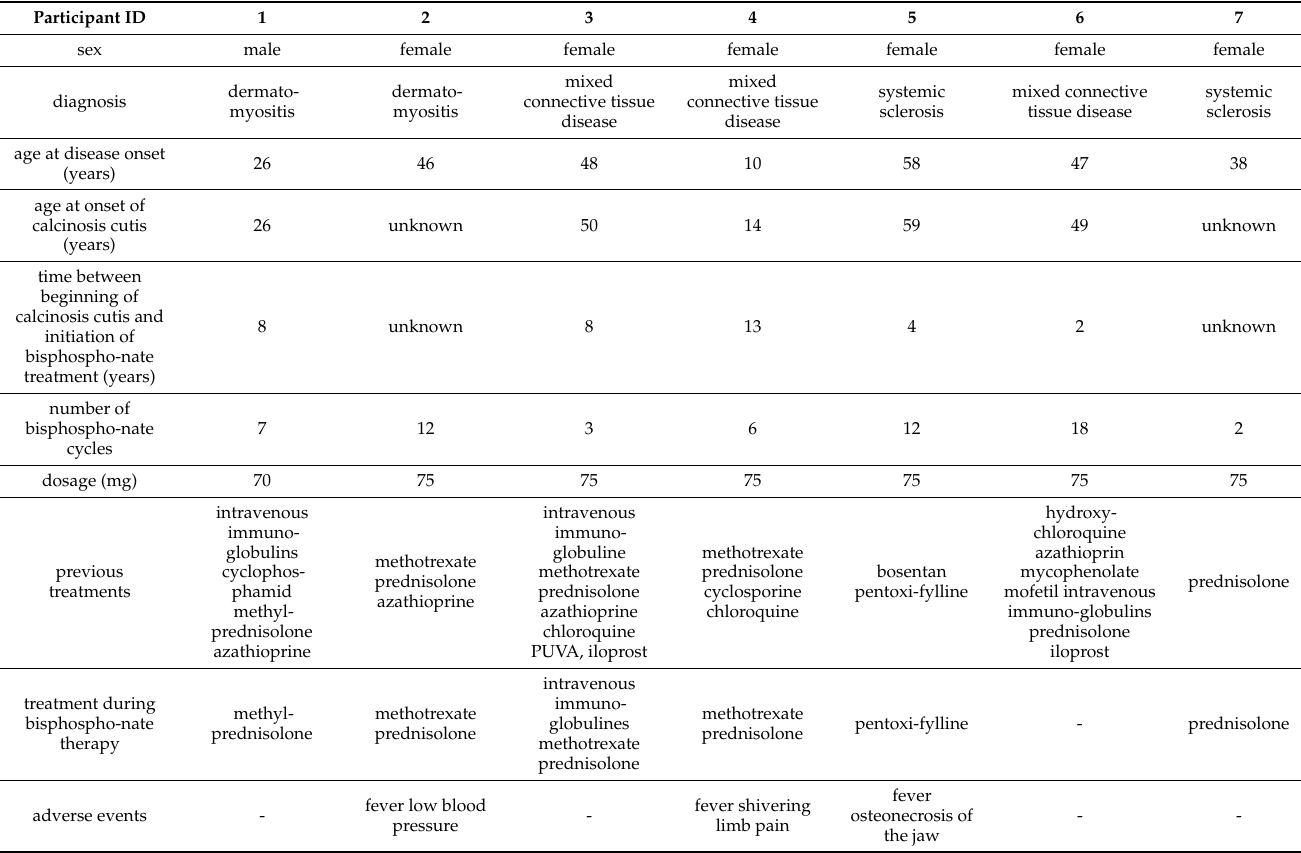
Table 1. Patients’